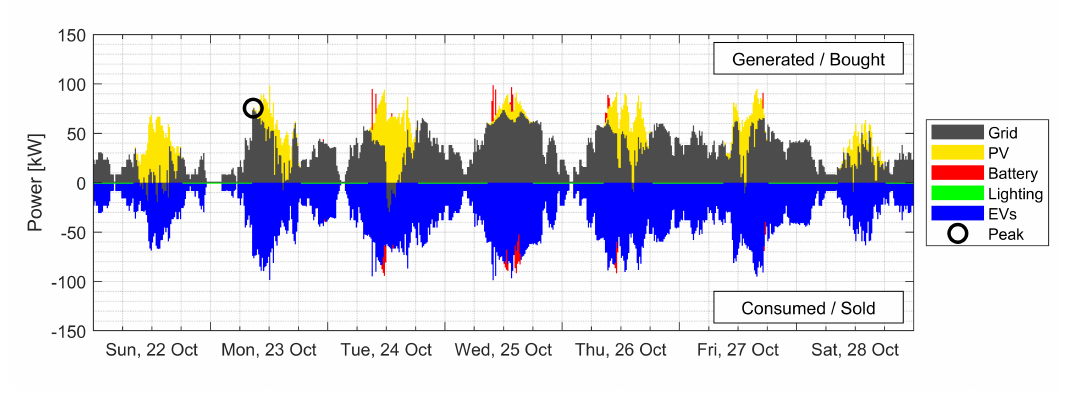
Figure 4. Comparison of energy flows in the solar parking lot with no EV demand forecast, a single average EV demand forecast and a robust consideration of EV demand